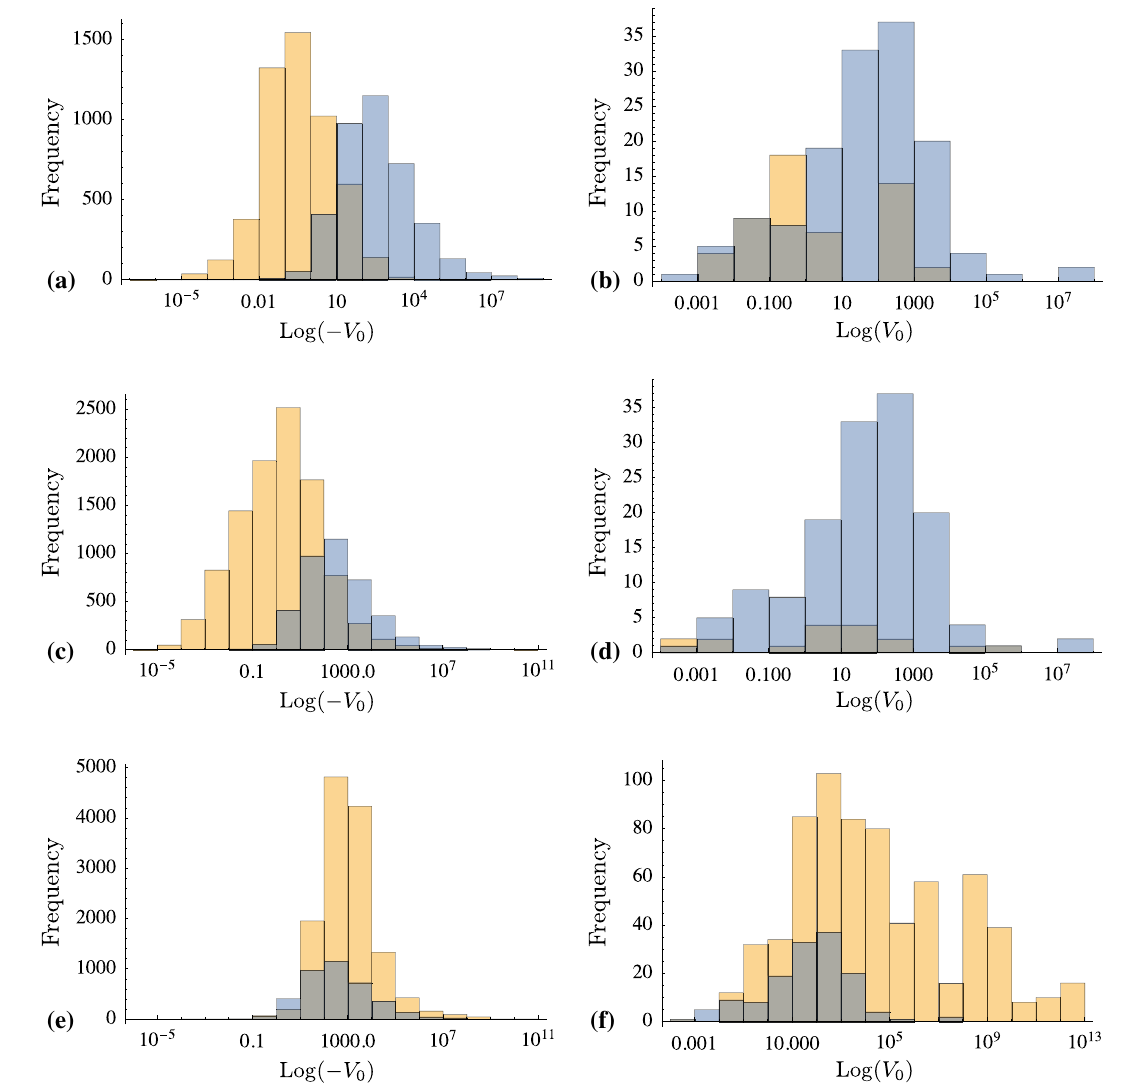
Fig. 6 Distributionsofvacuaforhierarchicalfluxes. a AdSvacua,case K, b dS vacua, case K, c AdS vacua, case AD, d dS vacua, case AD, e AdS vacua case CS, f dS vacua, case CS. All dS vacua are unstable. The critical points obtained by the ANN+GA are given in yellow bars,